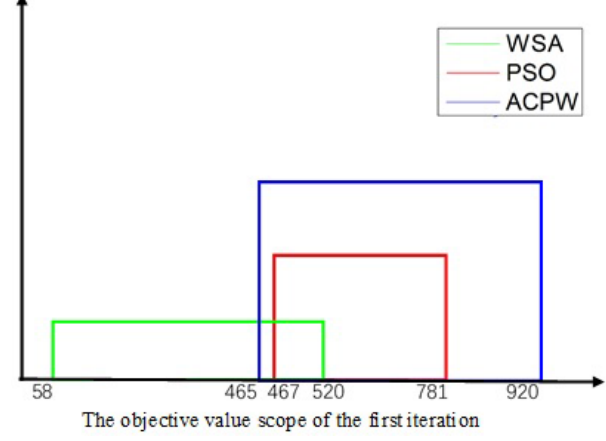
Figure 3. The first objective value scope of the PSO, WSA and ACPW methods. PSO is denoted as the red line, the WSA is shown as the green line and the ACPW algorithm is represented as the blue